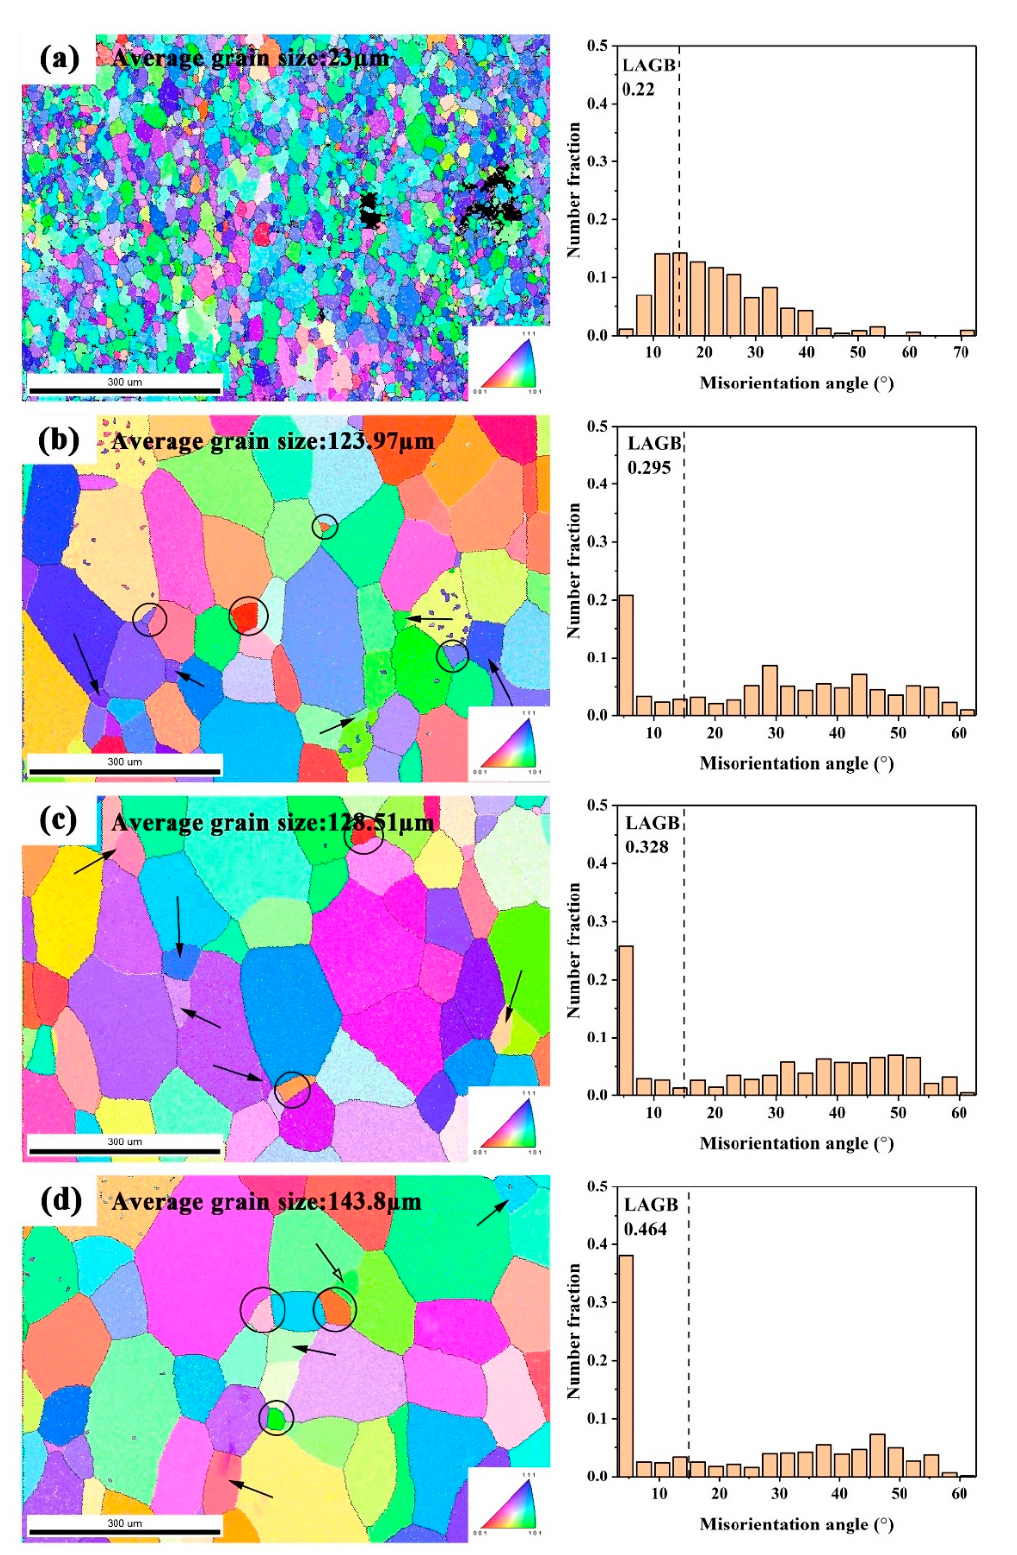
Figure 7. Electron backscattered diffraction (EBSD) figures after ( a ) 700 °C, ( b ) 750 °C, ( c ) 800 °C, ( d ) 850 °C first-pass compressing and then holding at 950 °C for 3 min.